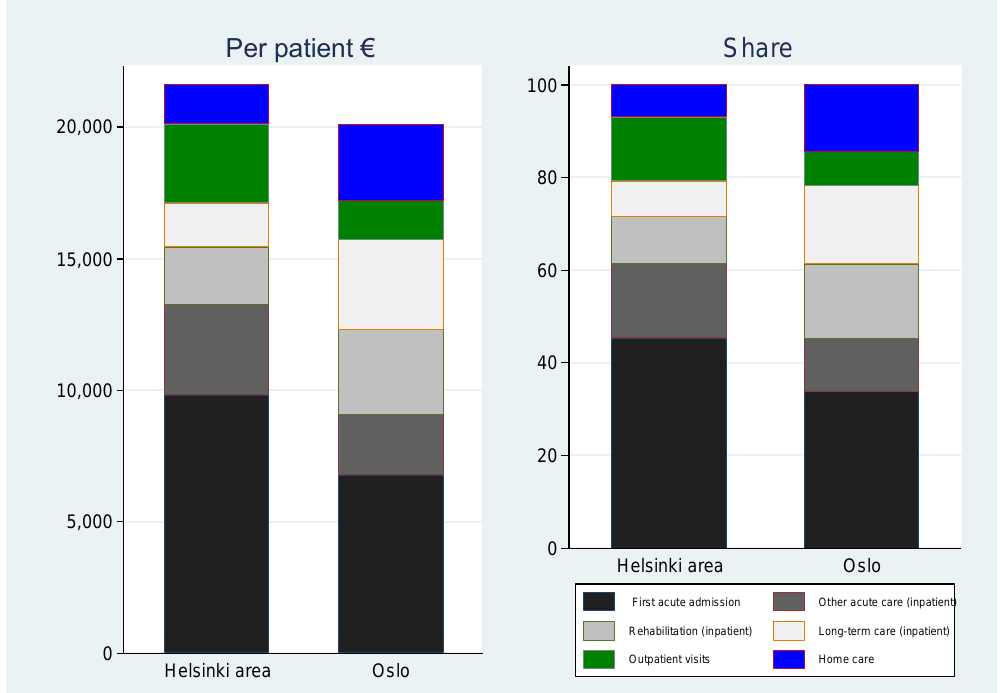
Figure A1: Structure of one-year total cost 2009-2013, Age, gender, STEMI and previous year use of hospital care